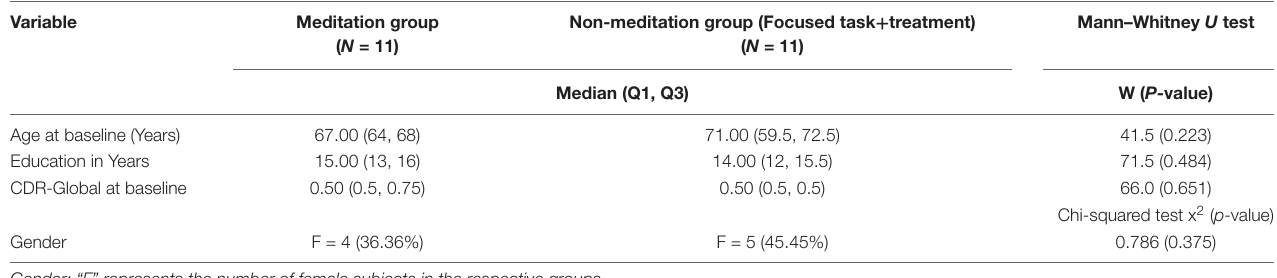
TABLE 3 | Demographics of participants who finished their baseline and follow-up neuroimaging scans.